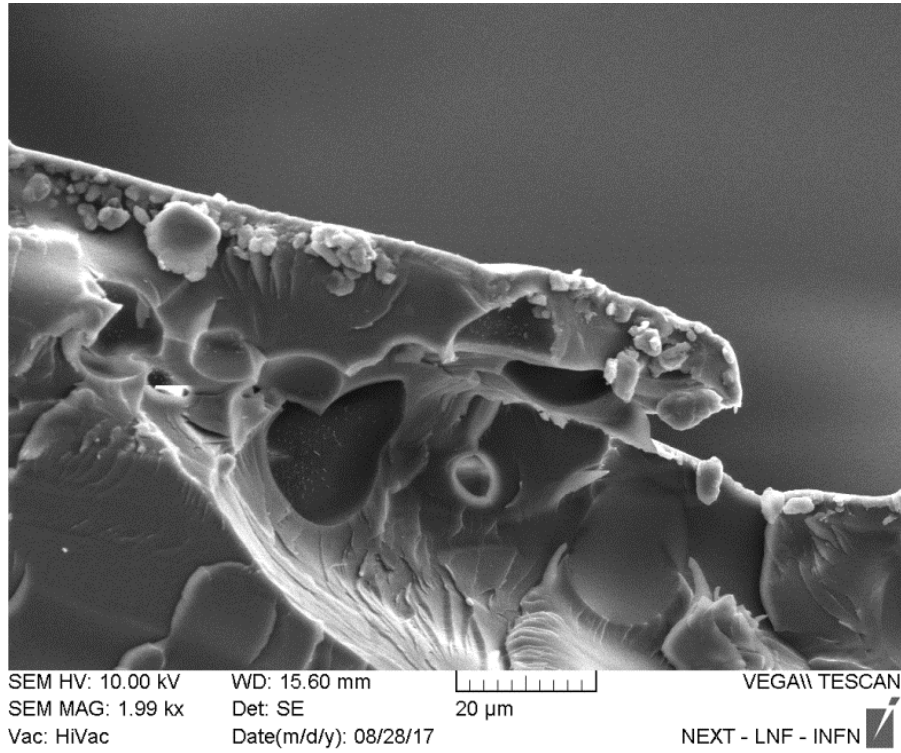
Figure 26. SEM images of the section of the resin sample at 1000 rpm.